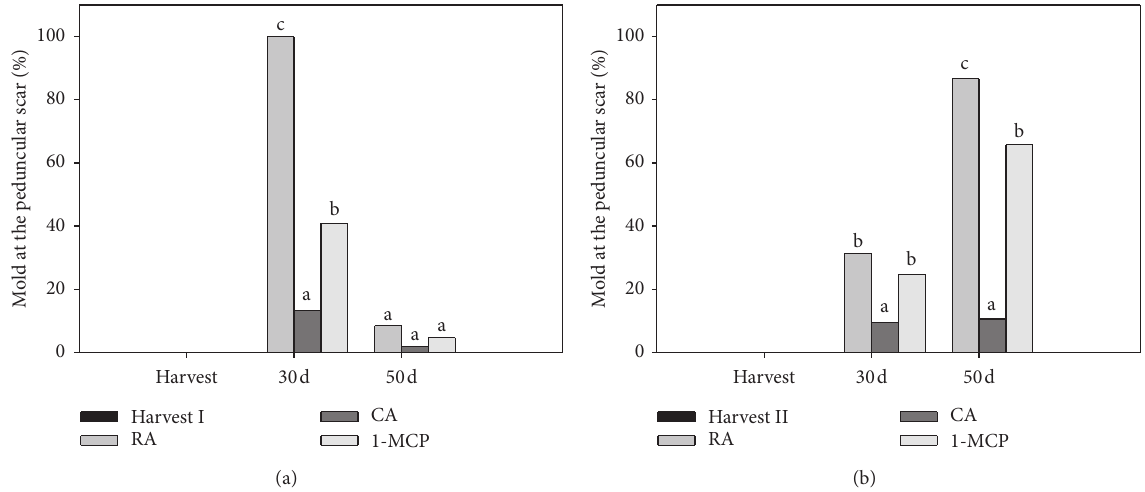
Figure 4: Incidence (%) of mold at the peduncular scar immediately after storage in “Edranol” avocado. (a) Harvest I and (b) Harvest II. RA: regular air. CA: controlled atmospheres (4% O 2 and 6% CO 2 ). Different letters within each storage period represent significant differences at P ≤ 0.05 as determined by the LSD test. d: